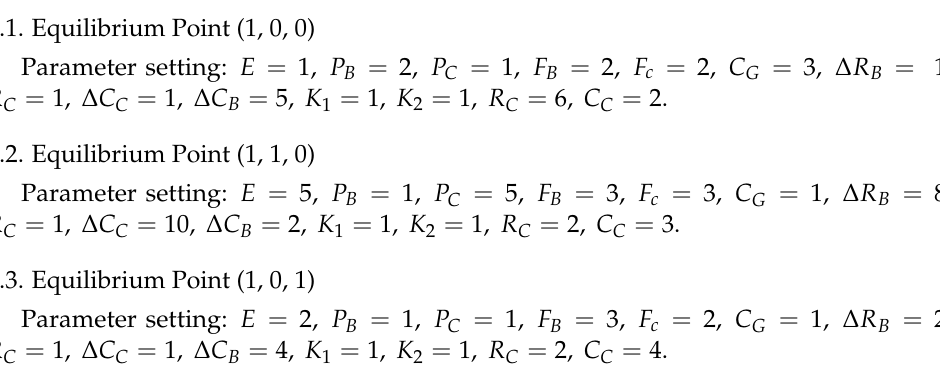
Figure 6. Evolution simulation development at mature stage point (0, 1, 1).